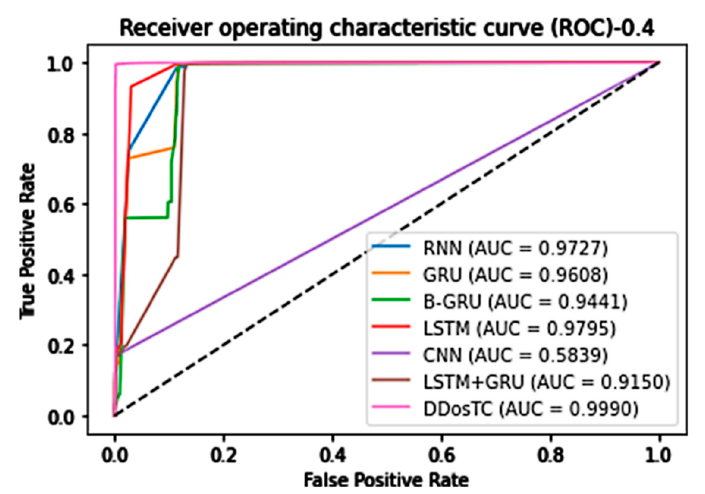
Figure 13. AUC for train/test = 7:3.